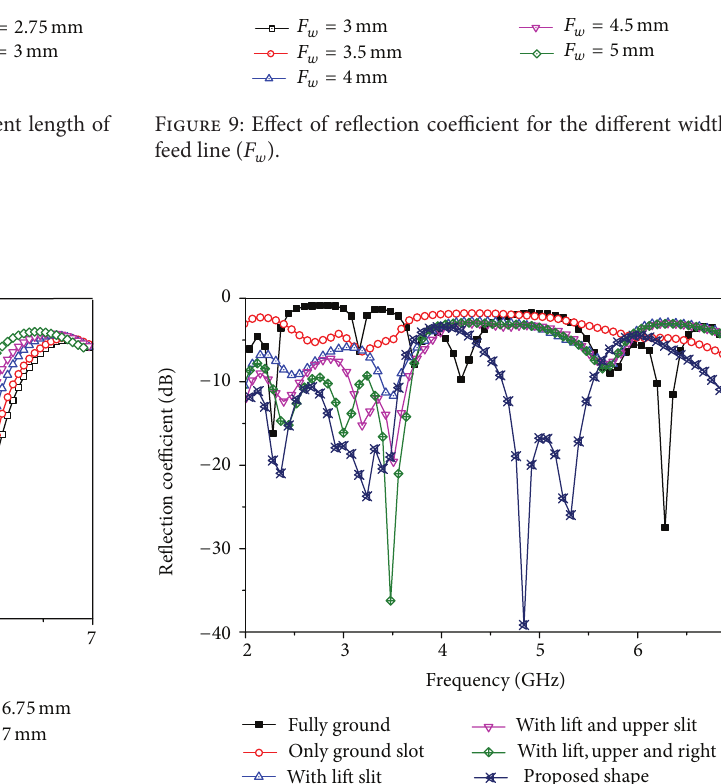
Figure 10: Effect of reflection coefficient for ground plane modifi-